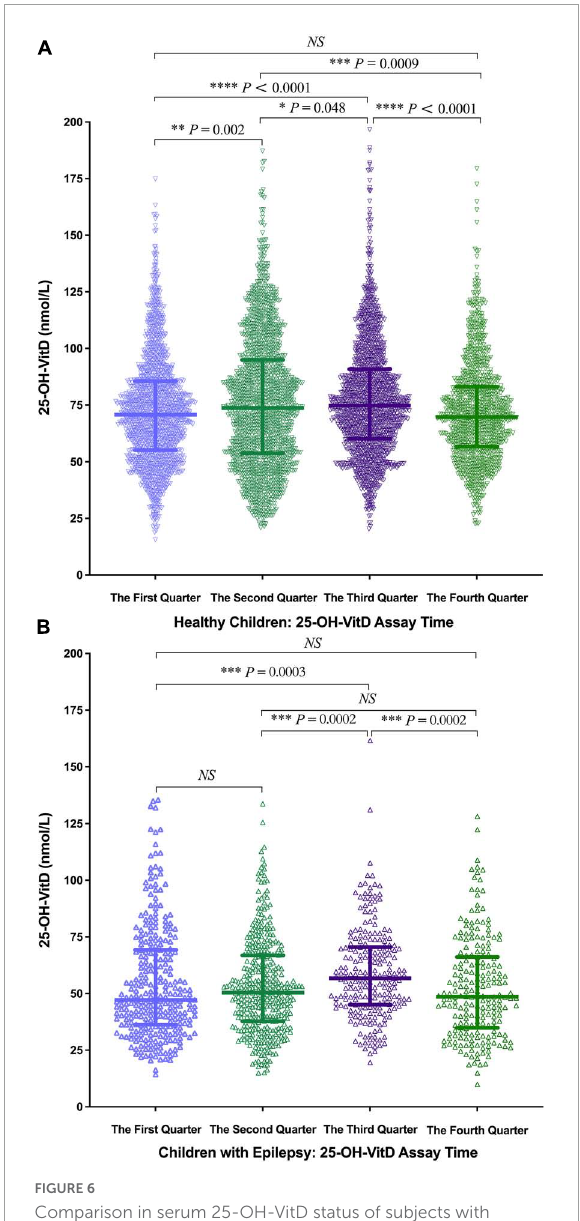
FIGURE6 Comparison in serum 25-OH-VitD status of subjects with different assay time. (A) Comparison in serum 25-OH-VitD status with different assay time of healthy children. (B) Comparison in serum 25-OH-VitD status with different assay time of children with epilepsy.